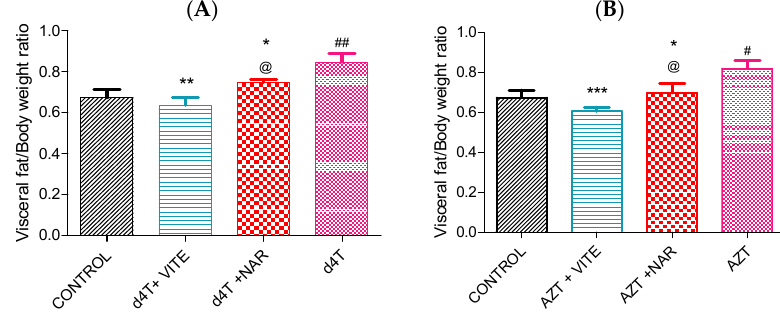
Figure 2. Adiposity index (calculated as a ratio of visceral fat mass to total body weight) among NRTI ‐ treated rats following 56 days of drug treatment. ( A ) d4T ‐ treated (## p < 0.01 compared to control; * p < 0.05 and ** p < 0.01 compared to d4T) and ( B ) AZT ‐ treated (# p < 0.05 compared to controls; *** p < 0.001 and * p < 0.05 compared to AZT) rats. @ p < 0.05 compared to vitamin E among both d4T and AZT ‐ treated rats.